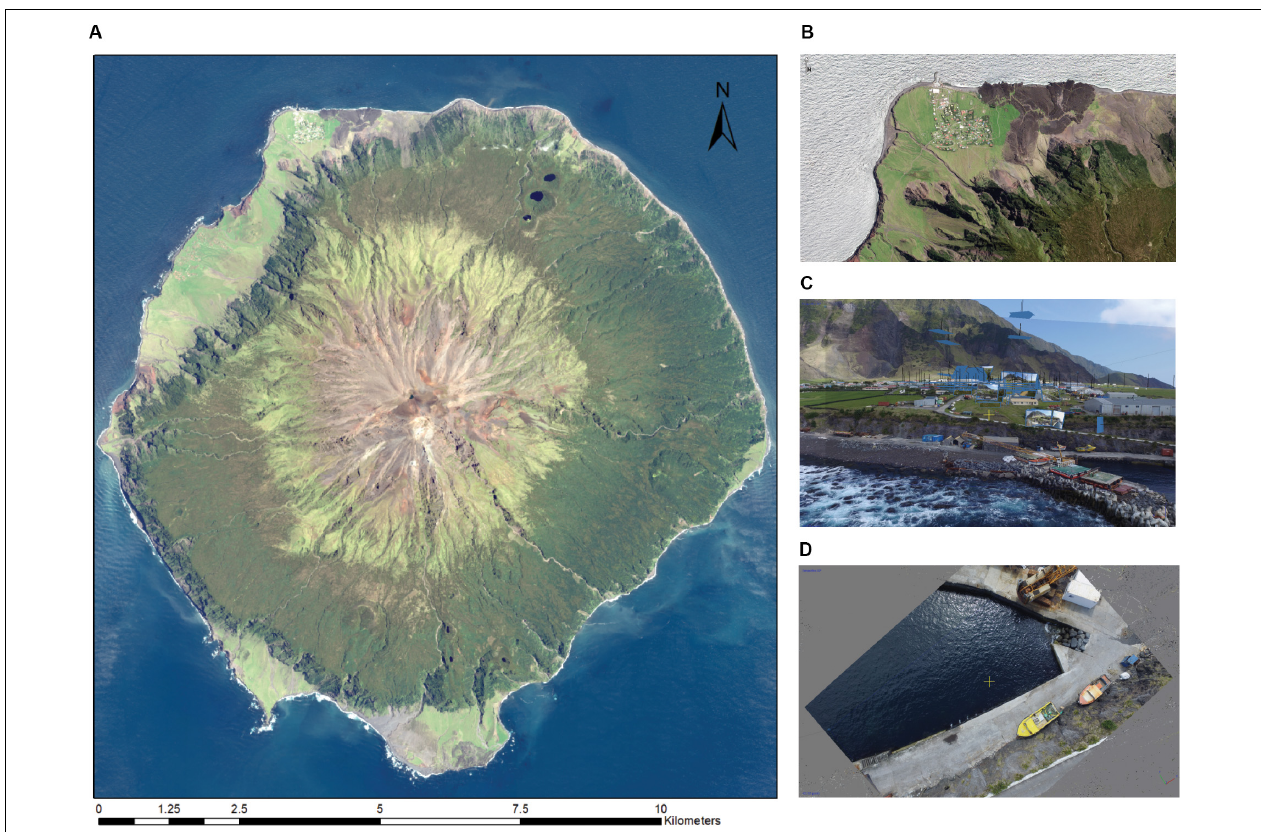
FIGURE 1 | (A) Satellite image of Tristan da Cunha courtesy of the DigitalGlobe Foundation. (B) Zoom to Edinburgh of the Seven Seas. (C) Perspective view based on drone imagery. (D) Low-altitude drone